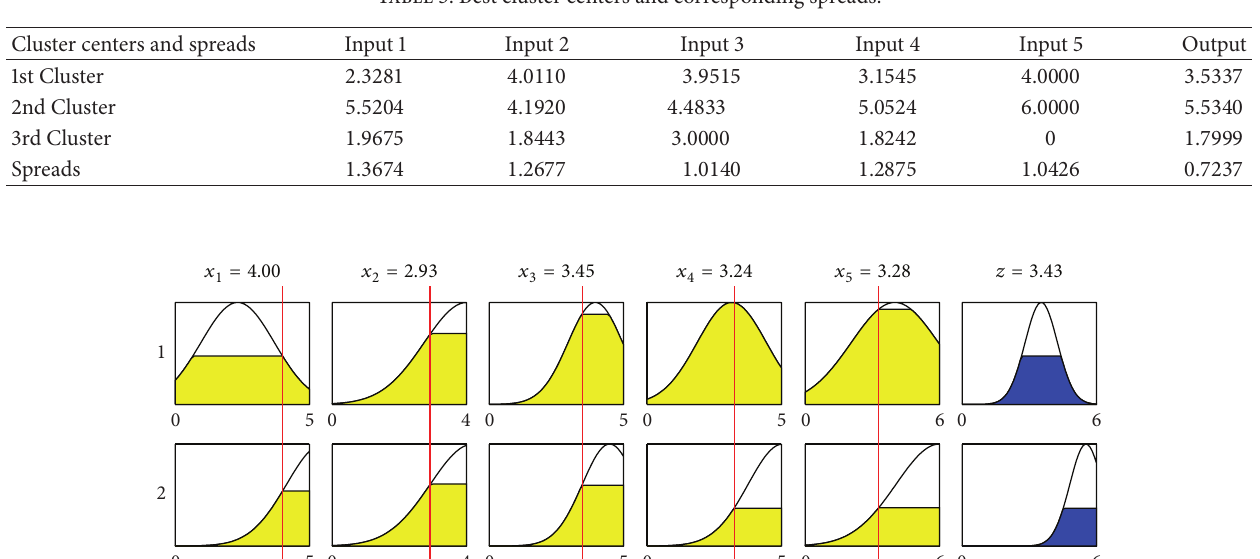
Table 3: Best cluster centers and corresponding spreads.